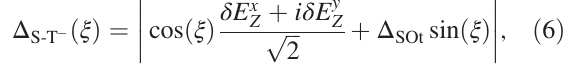
FIG. 4. Singlet-triplet T − mixing as a function of magnetic field direction. (a) Square of the coupling strength of singlet and triplet T − states as a function of external magnetic field in-plane angle. Inset: Pulse sequence used to measure the coupling. (b) Square of the coupling strength of singlet and triplet T − states as a function of external magnetic field out-of-plane angle while at φ in (a) and (b) the fit based on the SOI spin-flip model and the estimate from the differences in the off-diagonal terms in the g -tensors. Inset: Example fit of the triplet probability as a function of ramp rate across the